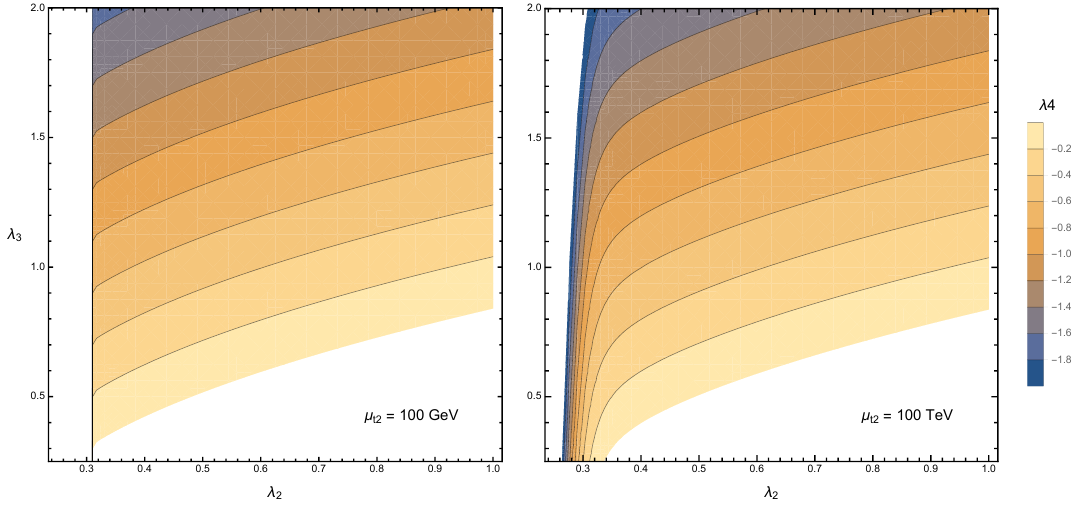
Figure 1 . Region of parameter space that leads to a 125 GeV SM-like Higgs boson for v 2 = 200 GeV, v t = 1 MeV and (cid:21) 1 = 0 : 6. In the left panel (cid:22) t 2 = 100 GeV and in the right panel, (cid:22) t 2 = 100